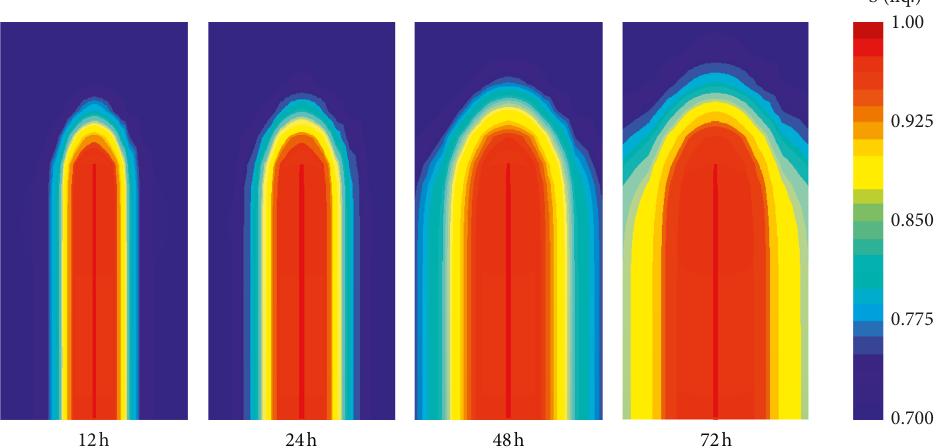
Figure 11: Simulated saturation profiles of working conditions 1–4.